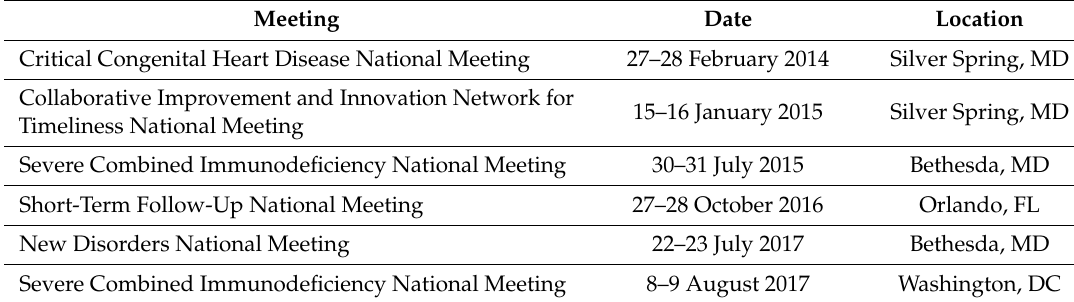
Table 6. NewSTEPs National